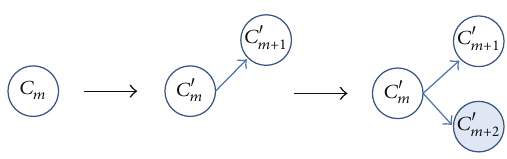
Figure 3: Cluster splitting